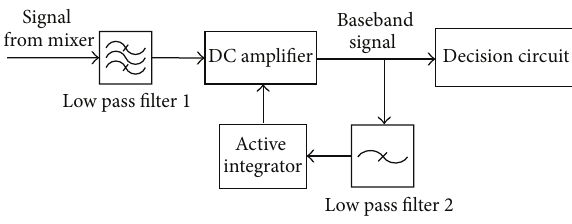
Figure 8: AC amplification distortions.